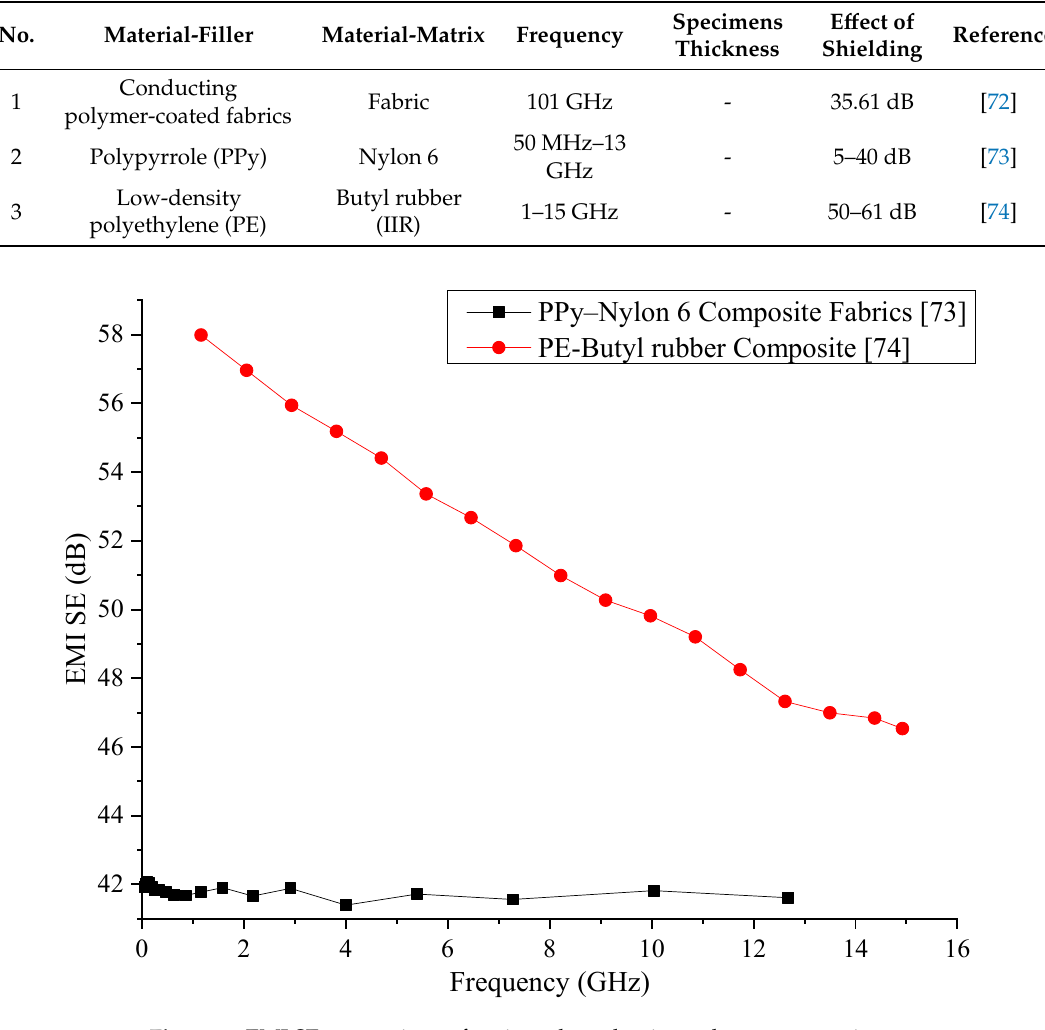
Figure 2. EMI SE comparison of reviewed conductive polymer composites.